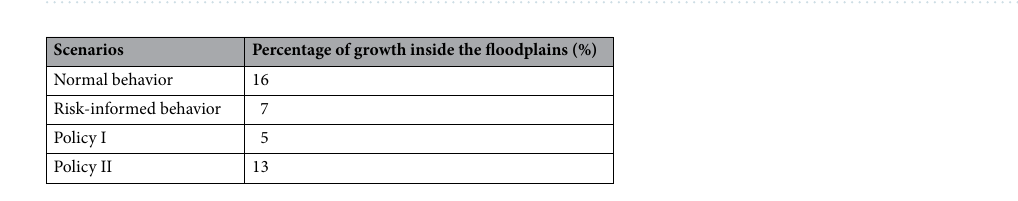
Figure 6. A biplots graph using the PCA analysis. The dots represent the housing prices and different colors are a range of prices on a logarithmic scale.